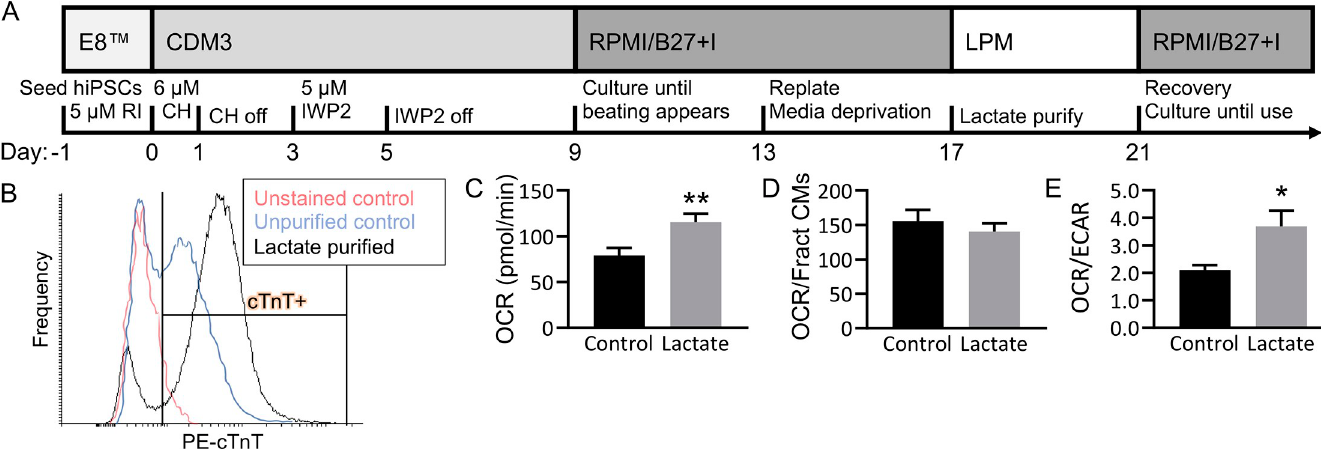
Fig 4. HiPSC-cardiomyocytes increase oxidative phosphorylation with lactate purification. (A) Cardiomyocytes were differentiated from Gibco hiPSCs (GiPSCs). (B) Control cells (blue, 51% cTnT+) were cultured for the same duration (with no starvation) and fed glucose medium, and lactate purified cells (black, 82% cTnT+) underwent glucose starvation and lactate purification from day 13 to 21 of culture. (C-E) Oxygen consumption rate (OCR; C & D) and extracellular acidification rate (ECAR), were measured at basal metabolic levels using a Seahorse XFe96 Analyzer, and values were normalized using a LIVE/DEAD stain. OCR was calculated independent of cardiac purity (C, �� P < 0.01) and normalized by cardiac purity (D, P = 0.46). (E) The ratio OCR/ECAR of Control (unpurified, 51% cTnT+) and Lactate (lactate purified, 82% cTnT+) samples was calculated ( � P < 0.05). N = 10 per group, bars represent mean ± SEM. (RI: rock inhibitor, CH: chiron, IWP2: inhibitor of wnt protein 2, CDM3: cardiac differentiation media 3, RPMI/B27 +I: RPMI/B27 with insulin, LPM: lactate purification media, cTnT: cardiac troponin T.).